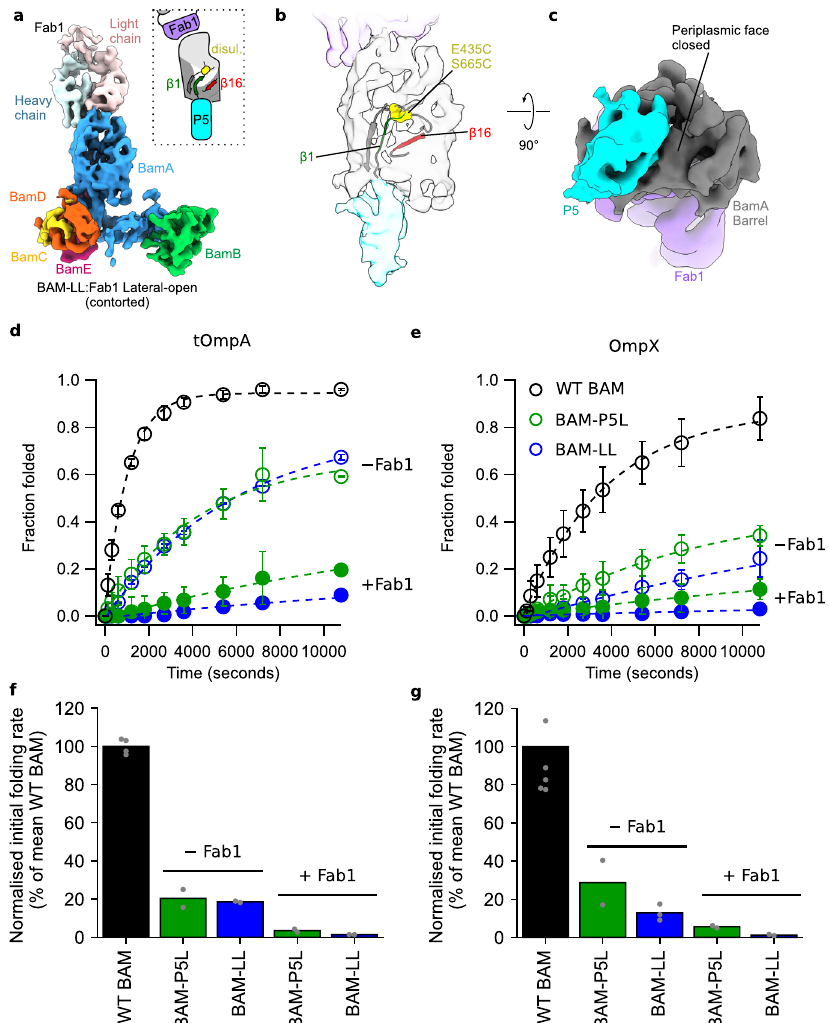
Fig. 4 Additive effect of BAM inhibition by disul fi de-locking and binding of Fab1. a 7.1 Å cryoEM map of the Fab1-bound LL-BAM in a lateral-open (contorted) conformation at a contour of 9.5 σ , coloured by subunit. The lateral gate is open and POTRA-5 occludes the BamA barrel ( schematic inset ). b Cartoon representation of the corresponding atomic model at the lateral gate, superimposed on the segmented density for the β -barrel and POTRA-5 of BamA. To satisfy the disulphide in this conformation, eL1 must bend back into the barrel to contact eL6. c The same density viewed from the periplasmic side, showing that the BamA lumen is blocked by POTRA-5 in this conformation. Structural panels made using UCSF ChimeraX 76 . Segmenting and colouring performed with corresponding atomic models. Less well-resolved regions and the micelle have been masked. d and e Quanti fi cation of SDS – PAGE band-shift assays shown in Supplementary Fig. 15 for d tOmpA and e OmpX folding catalysed by BAM-P5L + Fab1 ( green, solid circles ) and BAM-LL + Fab1 ( blue, solid circles ). Data for WT BAM ( black, open circles) , BAM-P5L ( green, open circles ) and BAM-LL ( blue, open circles ), from Fig. 1, are shown for comparison. Data markers represent the average folded fractions calculated from at least two repeats (The number of replicates is shown in Supplementary Table 1) and dashed lines are single exponential fi ts of the data. Error bars represent range of values covered by the replicates. f and g The initial rates, calculated by applying a linear fi t to the fi rst 5% of fi tted folding data, were normalised to the mean value for WT BAM, and are shown for f tOmpA and g OmpX folding. Bars represent the mean value for each condition, with values for each replicate shown as grey points. Average initial rates, normalised data and ranges are listed Supplementary Table 1. Folding yields after 24 h are reported in Supplementary Table 2. Figures labelled with “ BAM ” refer to the full BAM complex (BamABCDE), whilst “ BamA ” is just BamA alone. Source data for d – g are provided as a source data fi